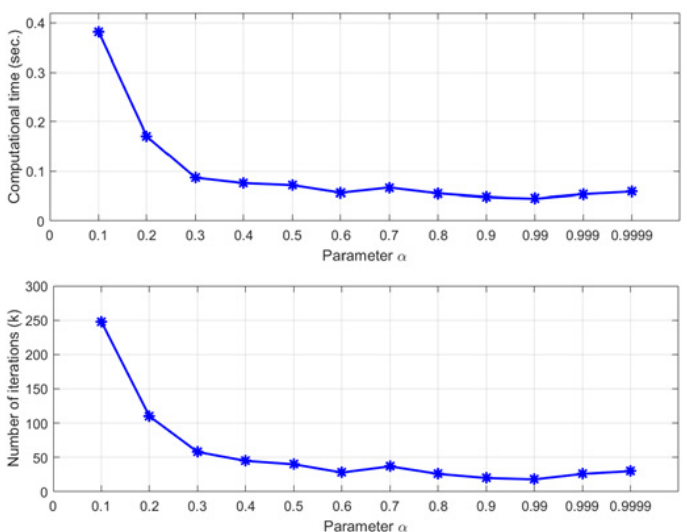
Figure 3. Effect of 𝑎 > 0 for